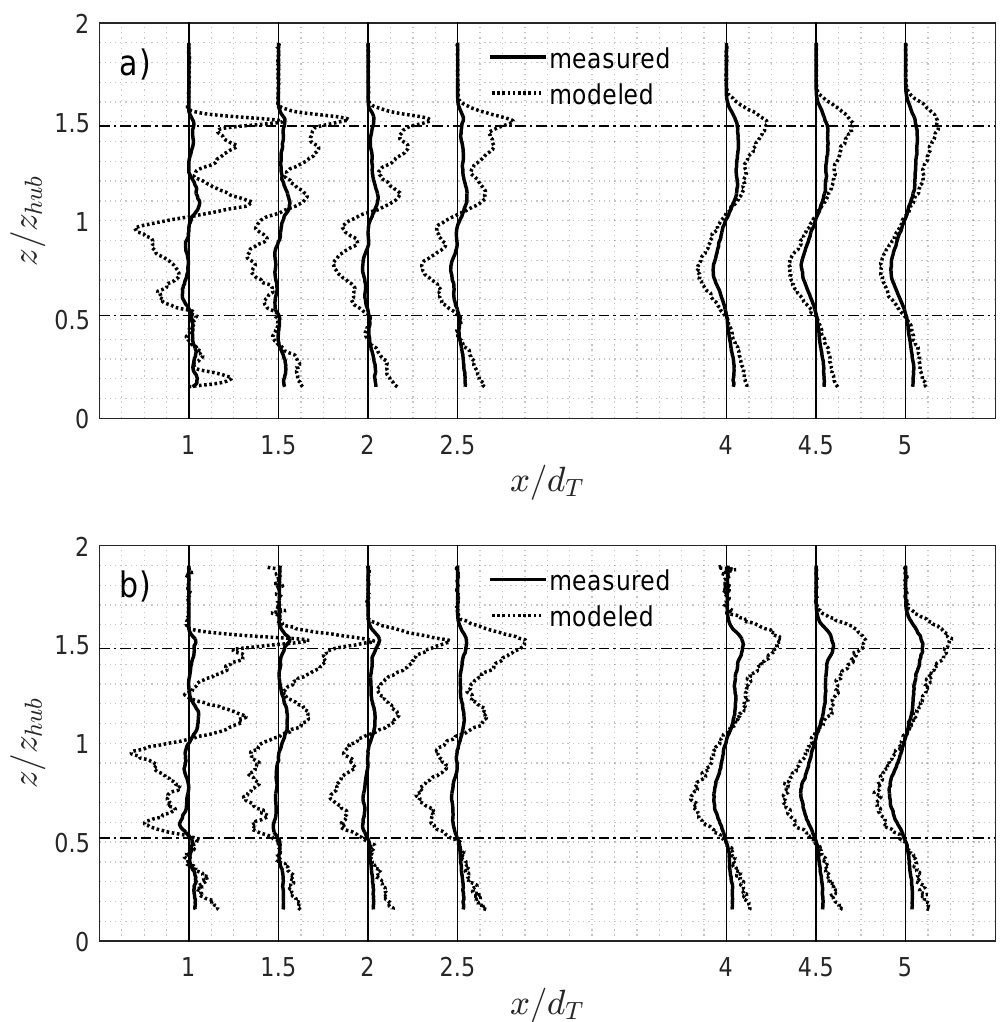
Figure 10. Comparison between measured kinematic Reynolds stress and the shear-based mixing length model. ( a ) Base turbine; ( b ) wingletted turbine. Horizontal dash-dot lines indicate the location of the bottom and top tips of the turbine. Vertical solid lines indicate local zeros, and grid squares have a width of 2 × 10 − 3 U 2 . hub